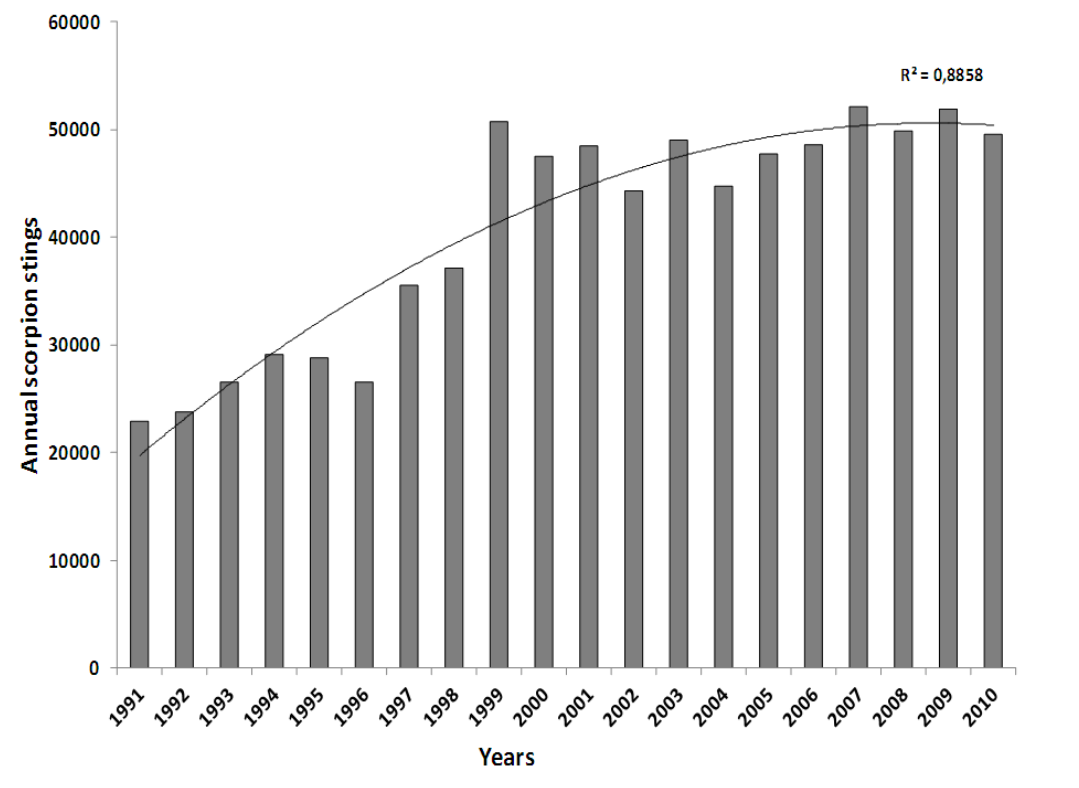
Figure 8. Trend of annual incidence of scorpion stings in Algeria from 1991 to